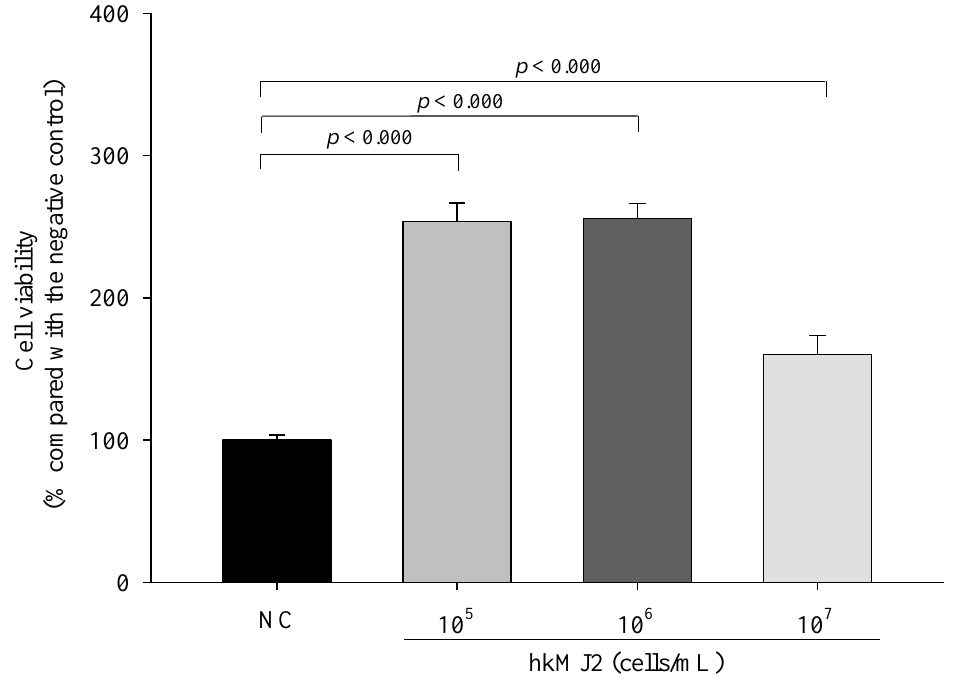
Figure 1. Cytotoxicity of hkMJ2 against RAW 264.7 cells. The values indicate the mean ± standard deviation (SD) of three independent experiments performed in triplicate. A Student’s t-test was used to determine the significance of the difference.